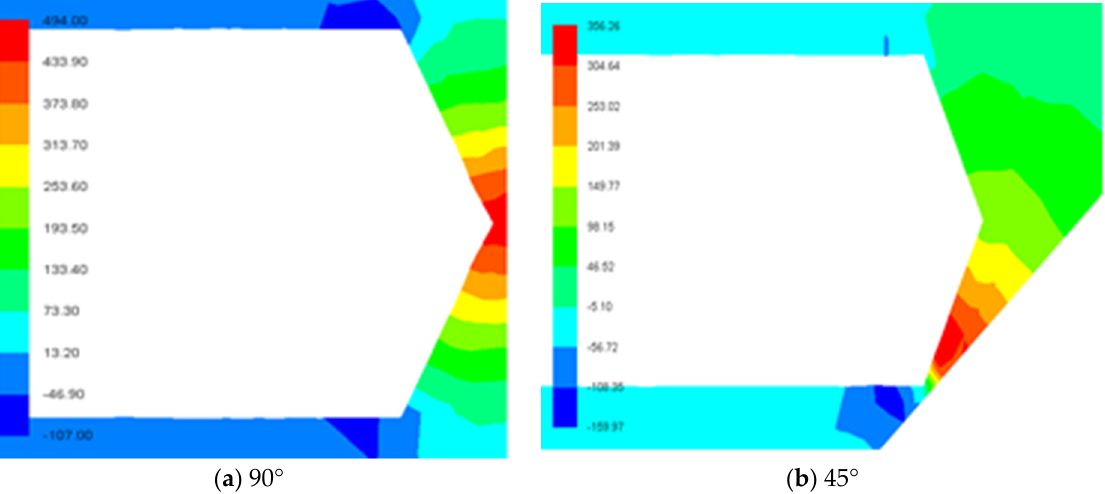
Figure 9. Pressure distribution of the two different shooting angles: ( a ) 90° and ( b ) 45°, at a speed of 10 m/s.